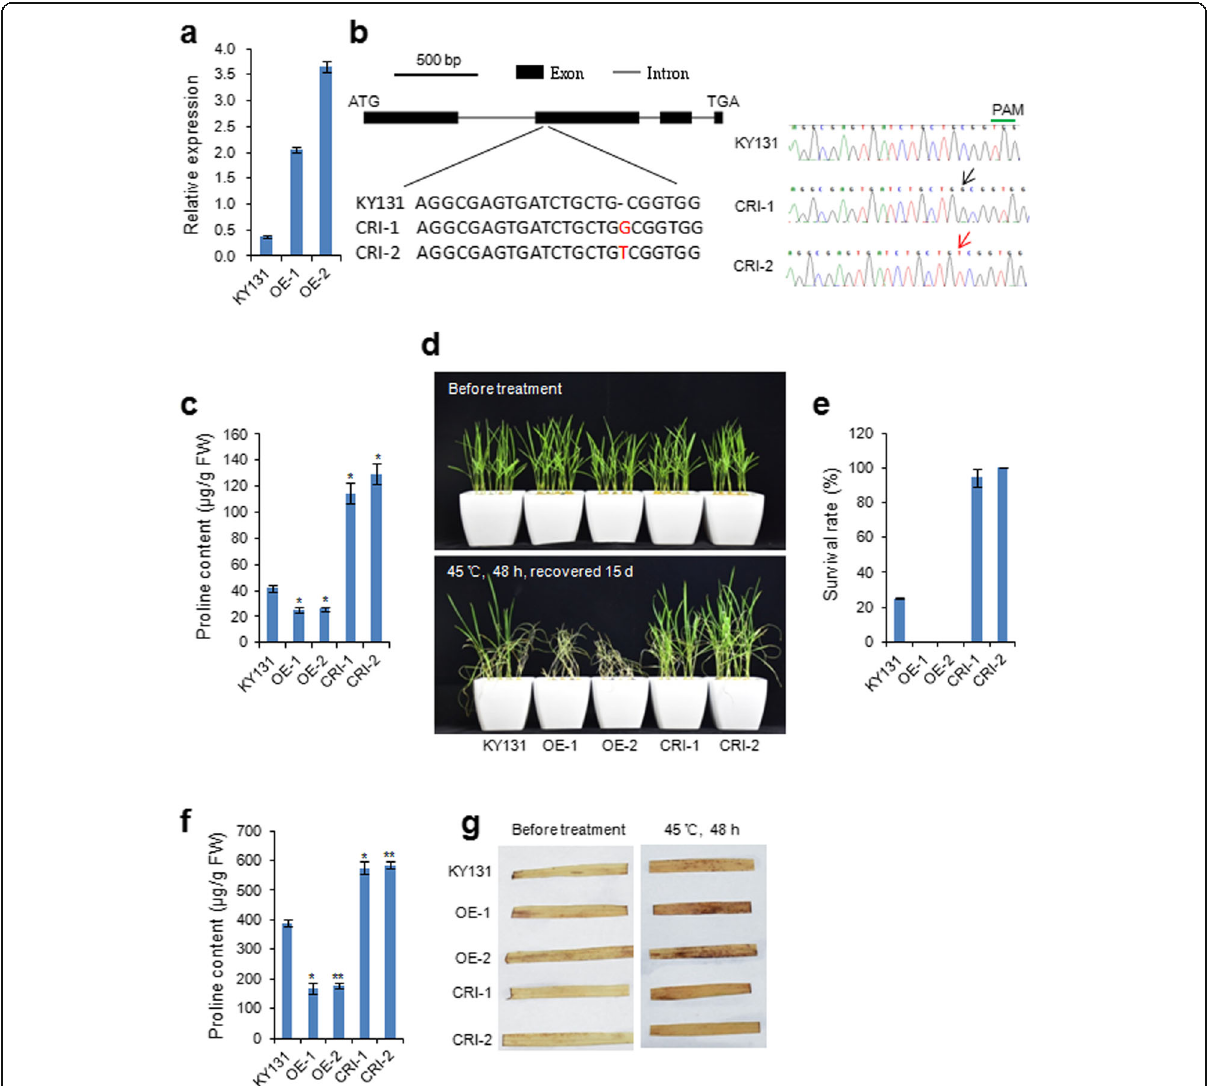
Fig. 3 OsProDH negatively regulates thermotolerance in rice a Transcript levels of OsProDH detected by qPCR in KY131 and transgenic two overexpression (OE) lines in shoots at the two-leaf stage rice seedlings. The data shown are the mean values of three technical repeats with the SD. b Gene structure of OsProDH and sequencing results at target sites in T1 plants produced by CRISPR/Cas9. c Proline contents of KY131, OE and CRI lines in shoots at the two-leaf stage rice seedlings under normal conditions. Values are the means ± SE, n = 3. Differences between the KY131 and transgenic lines were analyzed with Student ’ s t -test. (* P < 0.05). d Phenotypes of KY131, OE and CRI lines under 45 °C treatment. The two-leaf stage seedlings were subjected to high temperature treatment for 48 h and then recovered at normal conditions. e Survival rates of KY131, OE and CRI lines after recovering 15 days at normal conditions. ( n = 3 × 20). f Proline contents of KY131, OE and CRI lines in shoots at the two-leaf stage rice seedlings after 45 °C treatment for 48 h. Values are the means± SE, n = 3. Differences between the KY131 and transgenic lines were analyzed with Student ’ s t -test. (* P < 0.05; ** P < 0.01). g DAB staining of KY131, OE and CRI lines leaves from plants under normal (left) and stressed (right, 45 °C) conditions,